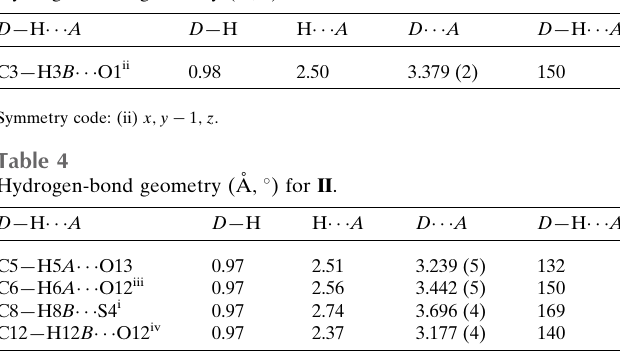
Table 3 Hydrogen-bond geometry (A˚ , (cid:5) ) for I .